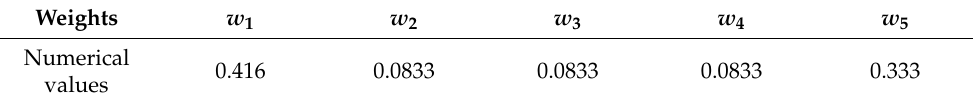
Table 7. Weight coefficient of each indicator layer.